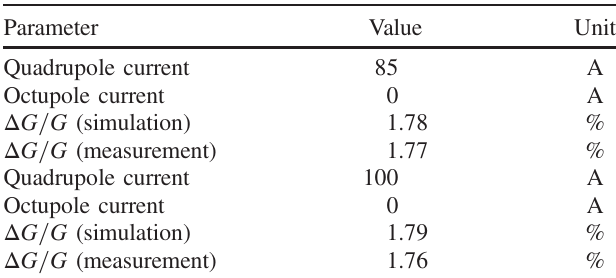
FIG. 10. Longitudinal distribution of the spurious gradient for a OD1 octupole (at 0 A) placed at 60 mm from a QF4 quadrupole (powered at 90 A).